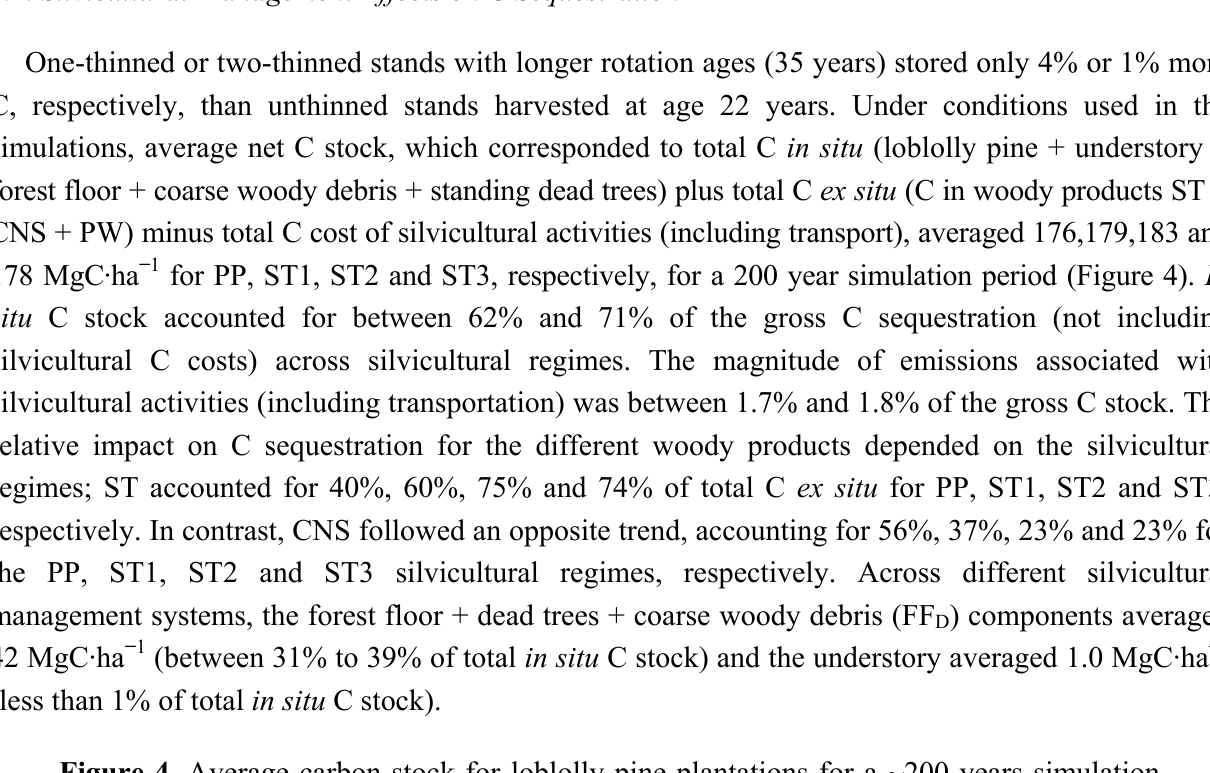
Figure 4. Average carbon stock for loblolly pine plantations for a ~200 years simulation period under different silvicultural